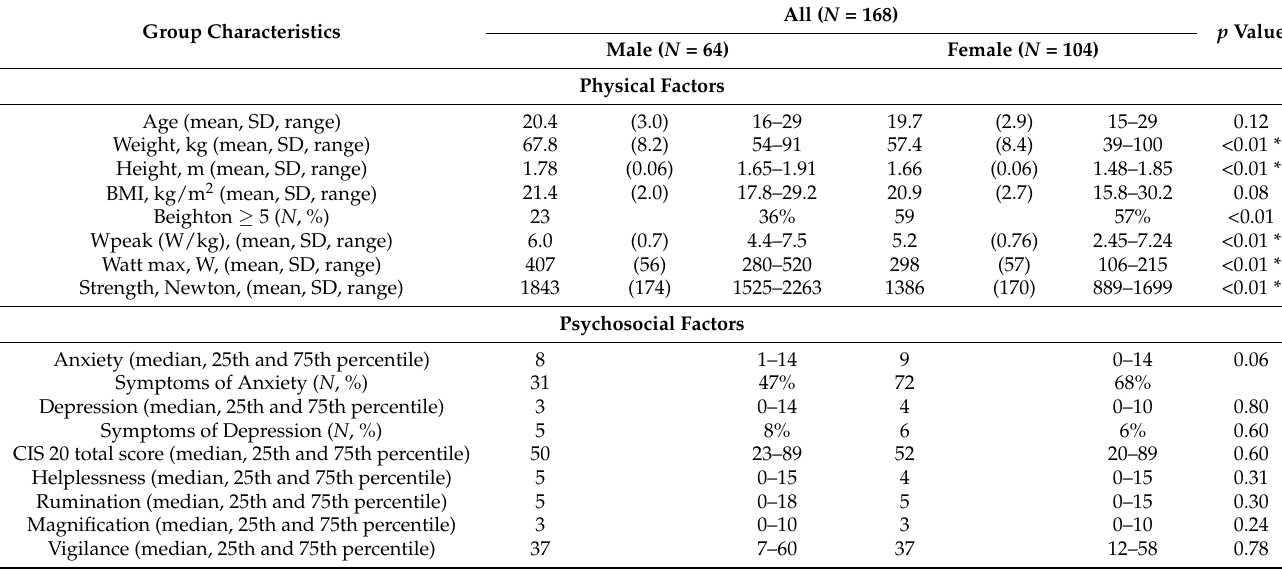
Table 1. Characteristics of all participants ( N = 168) by gender.